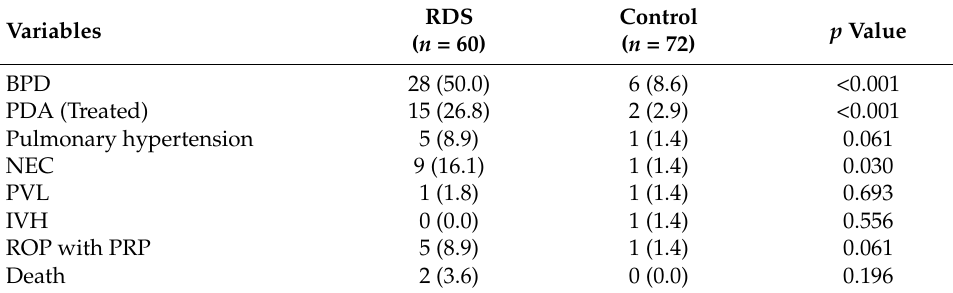
Table 2. Morbidity and mortality related to